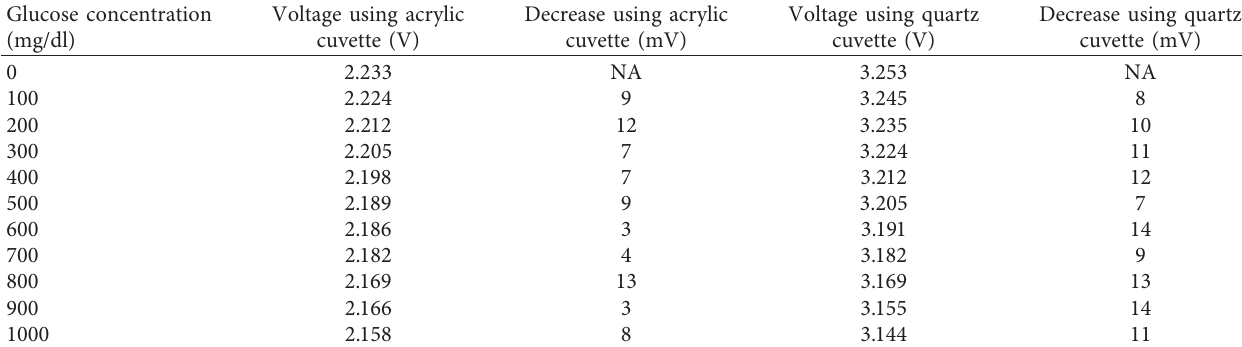
Table 3: Downward voltage pattern using acrylic and quartz cuvettes.